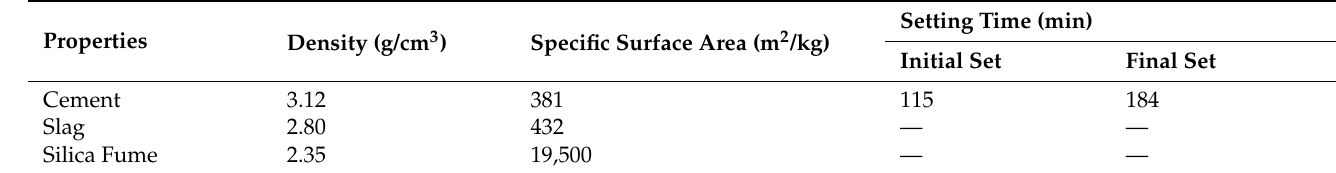
Table 5. Physical properties of cement, slag, and silica fume.